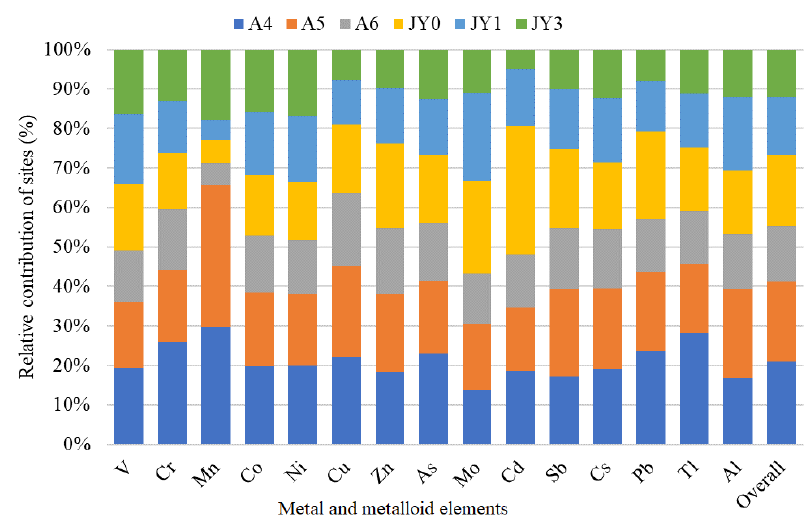
Figure 7. Relative contribution (%) of sites for metal and metalloid elements (MMEs) contamination in JRE obtained by SVD analysis and employing Equation (11).